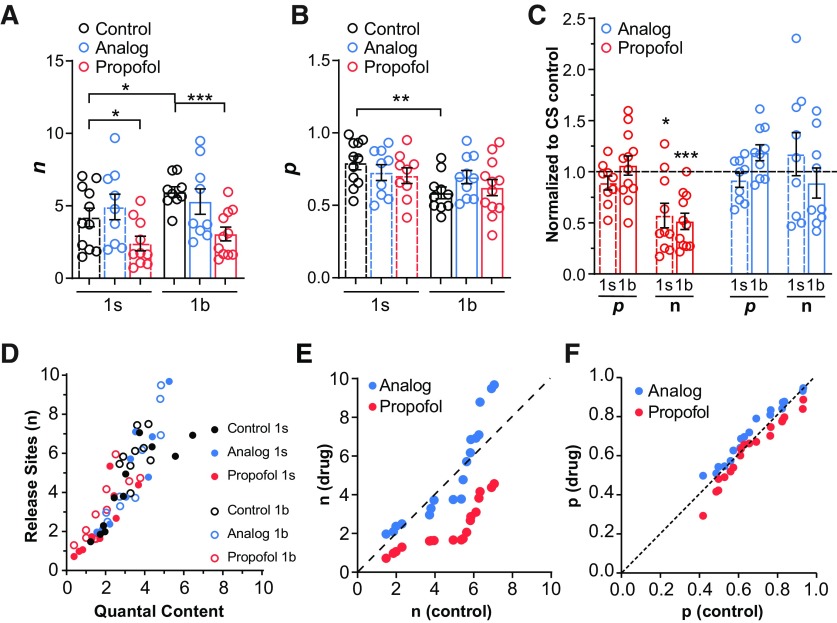
Propofol decreases the number of active release sites at synapses. A, Estimated number of active release sites (n; see Materials and Methods) in 1s and 1b boutons, for control and drug-treated conditions, in CS animals. B, Estimated release probability (p, see “Materials and Methods”) in 1s and 1b boutons, for control and drug-treated conditions, in CS animals. C, Data from A and B, normalized to non-drug-treated controls (dashed line). Graphs in A–C are averages ± SEM; individual data points (animals) are shown. *p < 0.05; **p < 0.01; ***p < 0.05, Student’s t test. D, Quantal content plotted against n, from all 1s and 1b recordings in control and drug conditions. E, Rank-ordered plot of n for drug versus control conditions. Dashed line indicates no effect of drug on n. F, Rank-ordered plot of p for drug versus control conditions. Dashed line indicates no effect of drug on p.